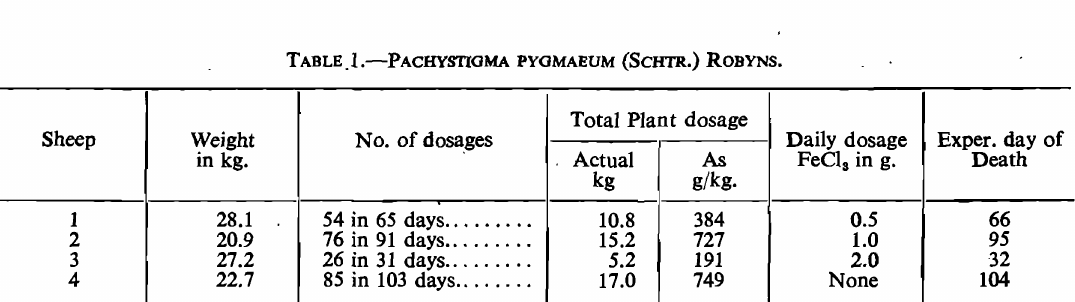
TABLE.1.-PACHYSTlOMA PYOMAEUM (SCHfR.) ROBYNS.